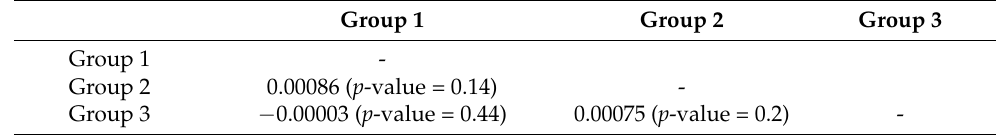
Table 5. F st distance between groups.